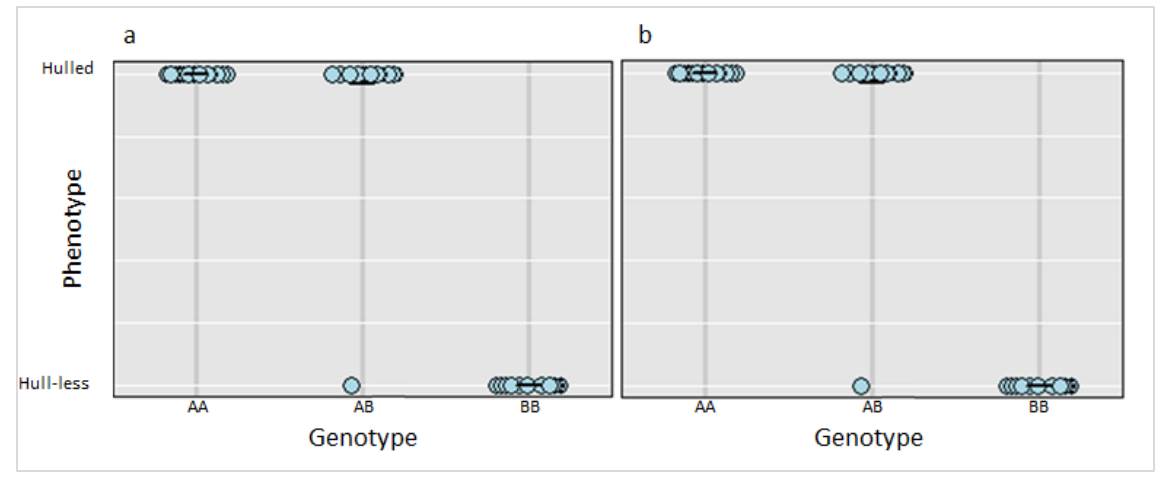
Figure 3. Genotype plot for SNP markers ( a ) Ch12_3412046 and ( b ) Ch12_3417142 in the F 2 population ( n = 143) and the corresponding phenotypic distribution. AA, AB and BB represent homozygous state for hulled phenotype, heterozygous state for hulled phenotype and homozygous state for hull-less phenotype, respectively. Each dot on the plot represents an F 2 individual in the population.